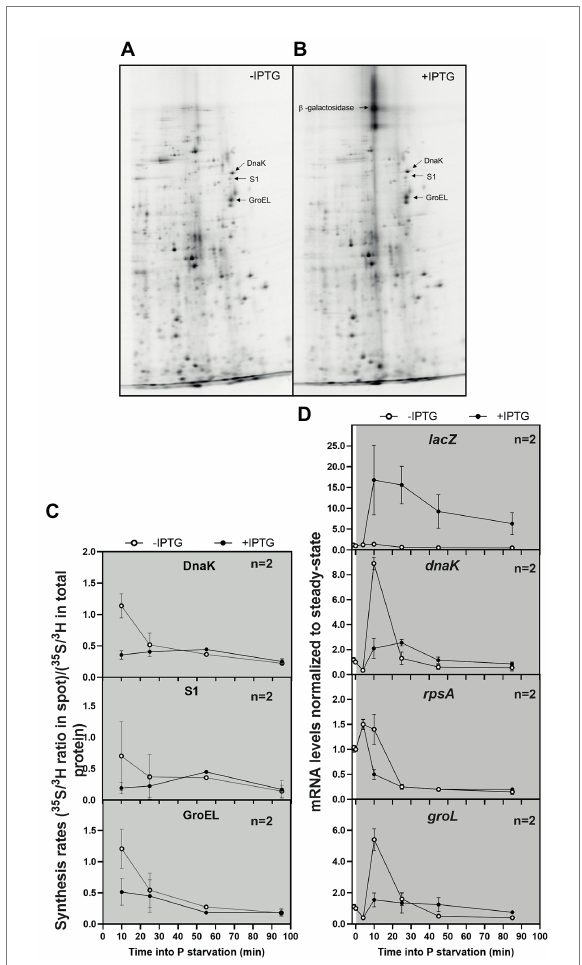
FIGURE 3 Effects of hybrid mRNA induction on expression of endogenous mRNA and protein. (A) Expression pattern of E. coli MAS1143/ pIV18 proteins from pulse labeling after 55 min of P starvation, shown on a 10.5% 2D PAGE gel. (B) As panel A, except IPTG was added to the culture at time + 5 min. (C) Expression levels